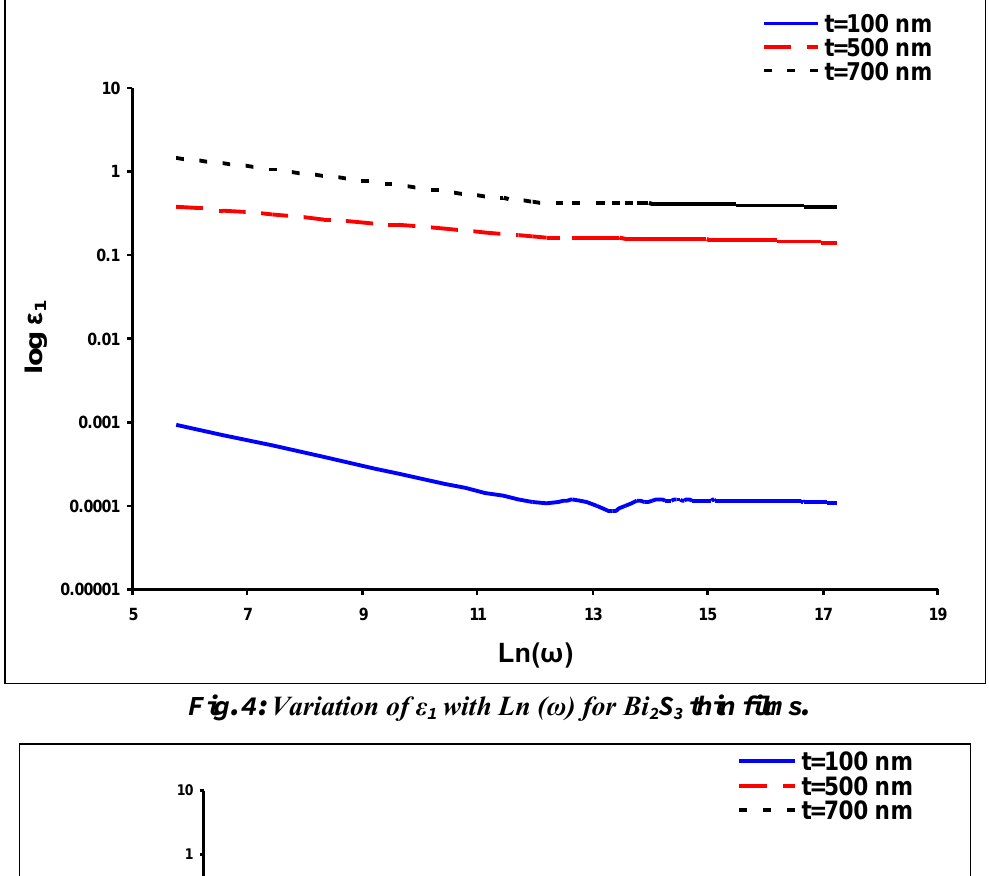
with Ln (ω) for Bi 1